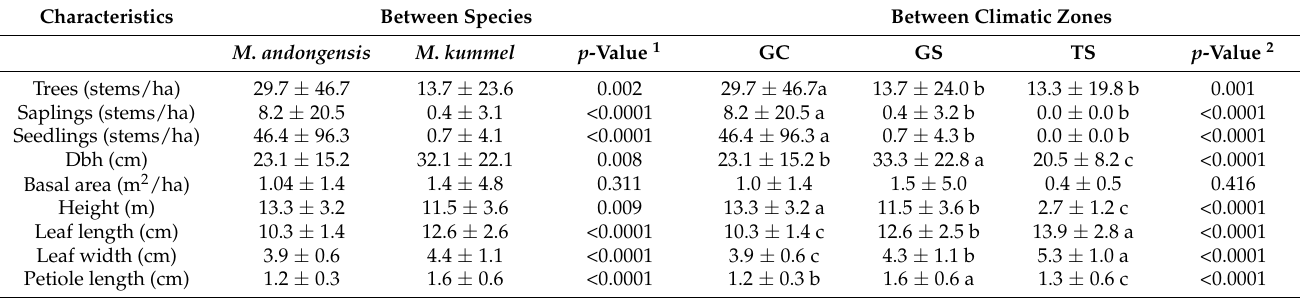
Table 2. Dendrometric and morphological characteristics (means ± SD) between species and bioclimatic zones. Characteristics Between Species Between Climatic Zones M . andongensis M . kummel p -Value 1 GC GS TS p -Value 2 Trees (stems/ha)